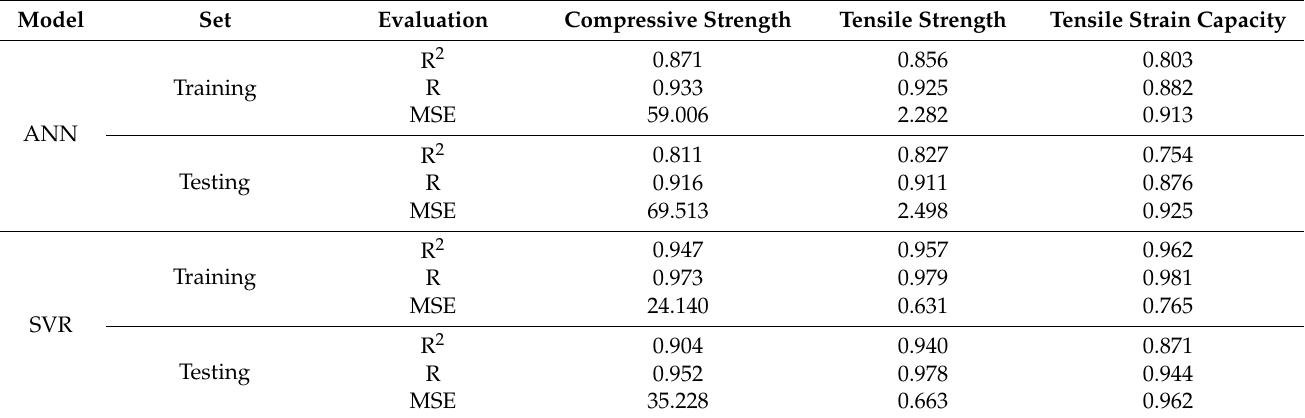
Table 5. Evaluation of prediction results from the machine learning models. Model